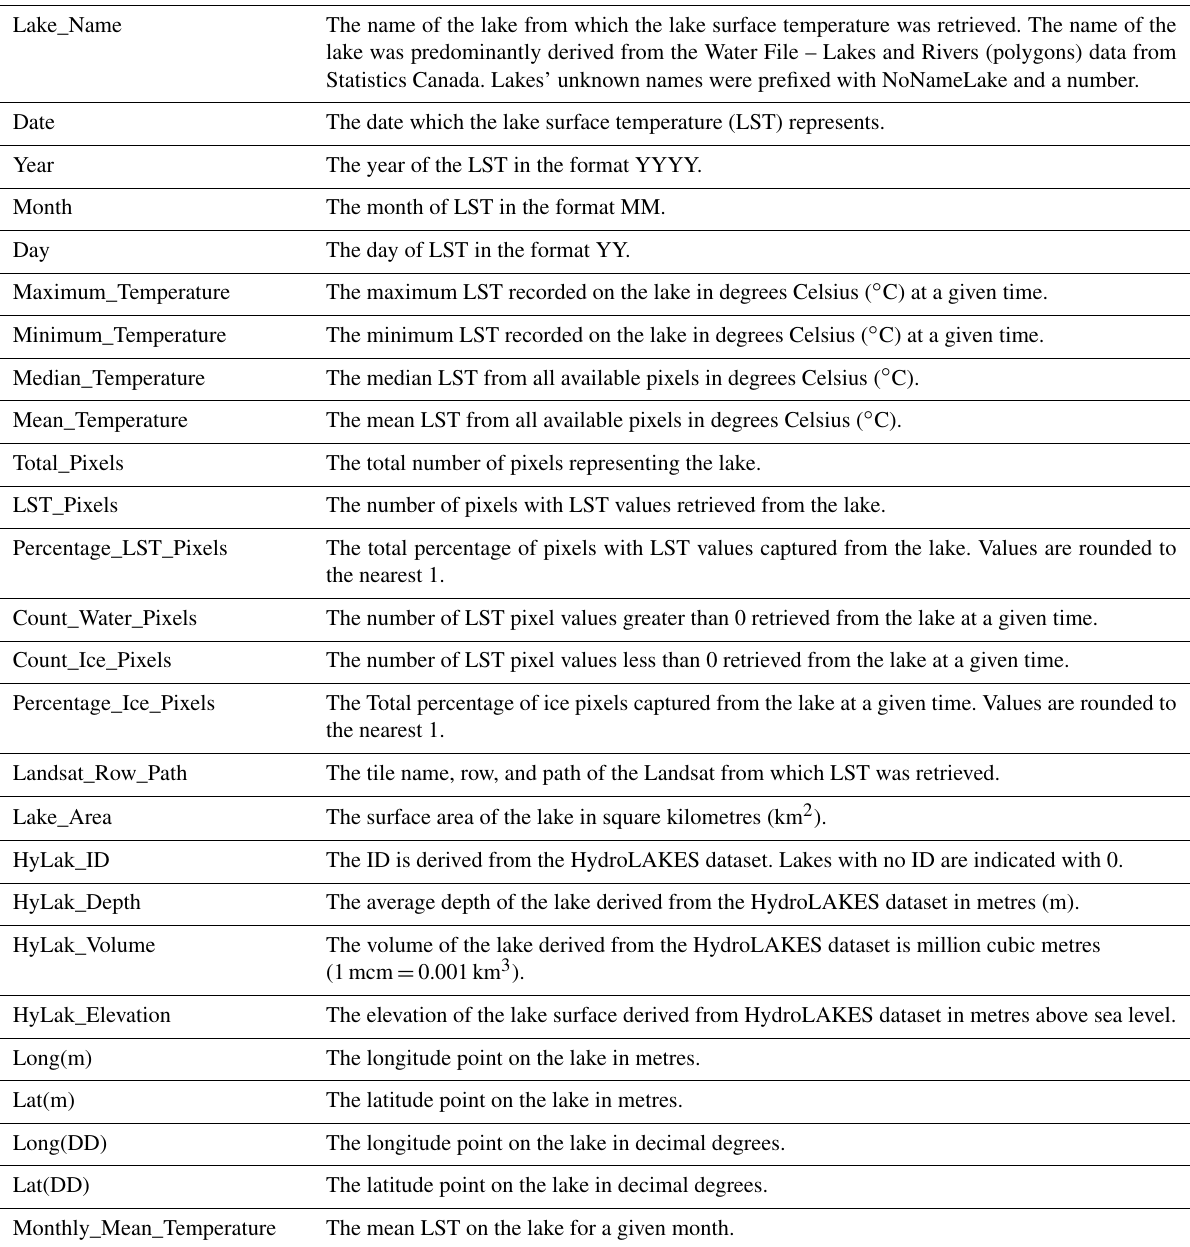
Table 4. Column names of the tabular dataset and the description.